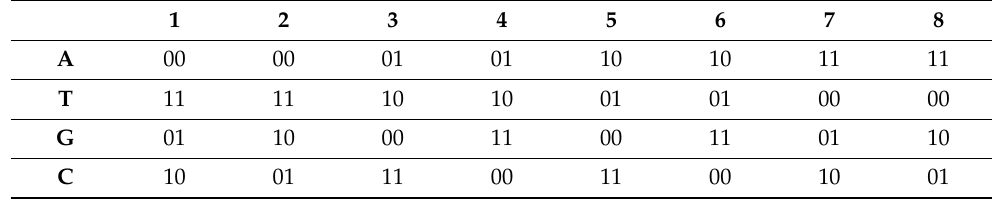
Table 1. Eight kinds of DNA map rules.